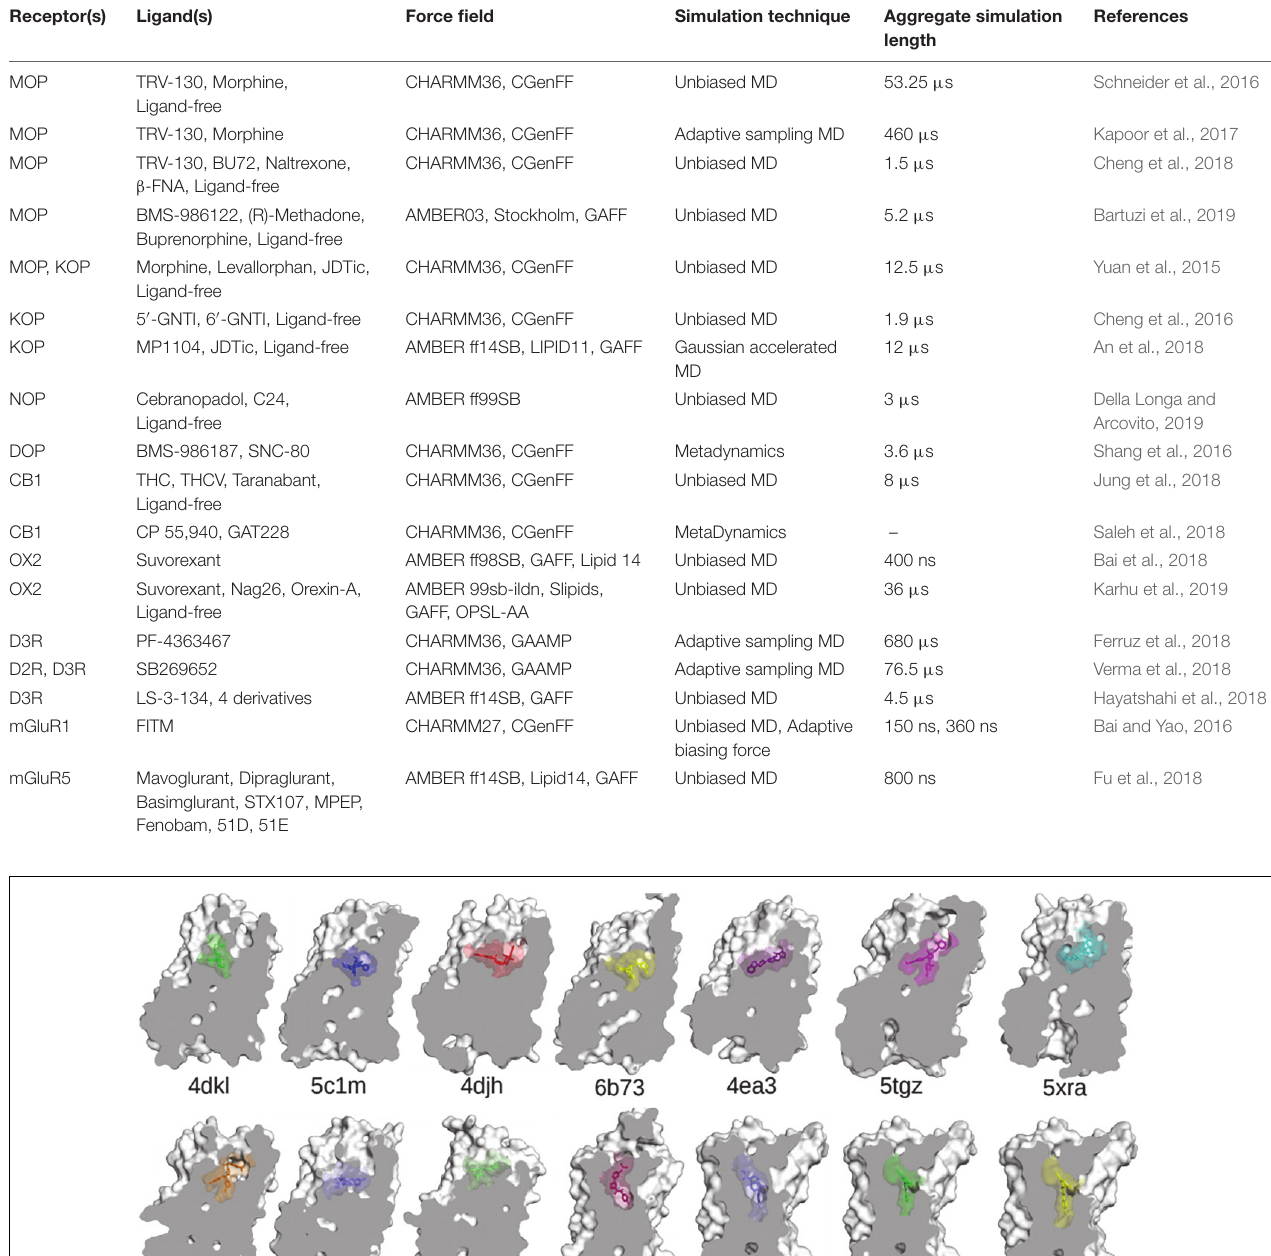
TABLE 1 | A compilation of the MD-based studies that have been reported in this review article.